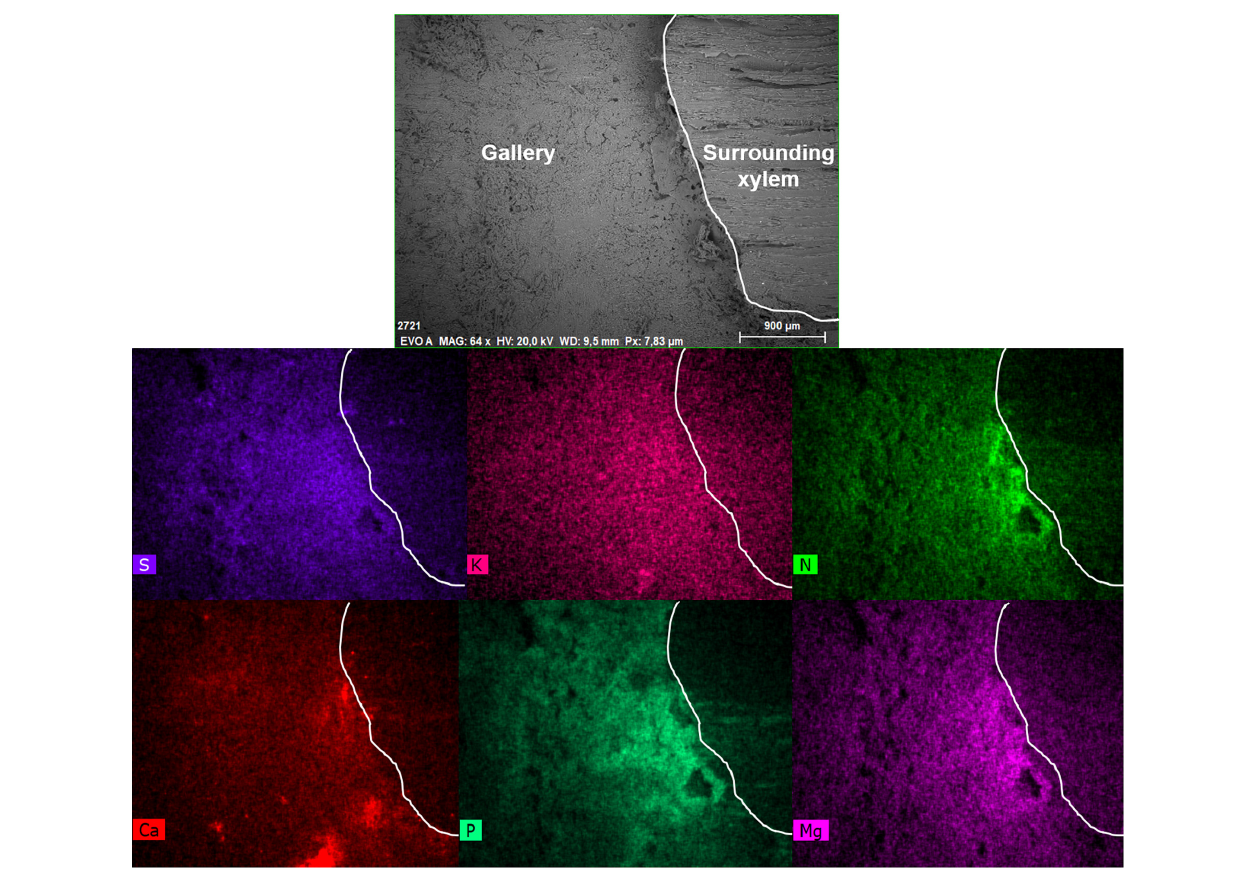
FIGURE 2 | Visualization of elements within a gallery of Xyleborinus saxesenii (ID = X.sax2) using the mapping function of the SEM-EDX. The SEM image on top (EVO A) is the inside of the gallery (left) and the surrounding xylem (right, starting from the ridge). The border from gallery to surrounding xylem was indicated with a white line in each image. Scale bar and magnification (64 × ) are given at the bottom of the image. The intensity of the colors in the images below reflect the abundance of the elements sulfur (S), potassium (K), nitrogen (N), calcium (Ca), phosphorus (P), and magnesium (Mg).